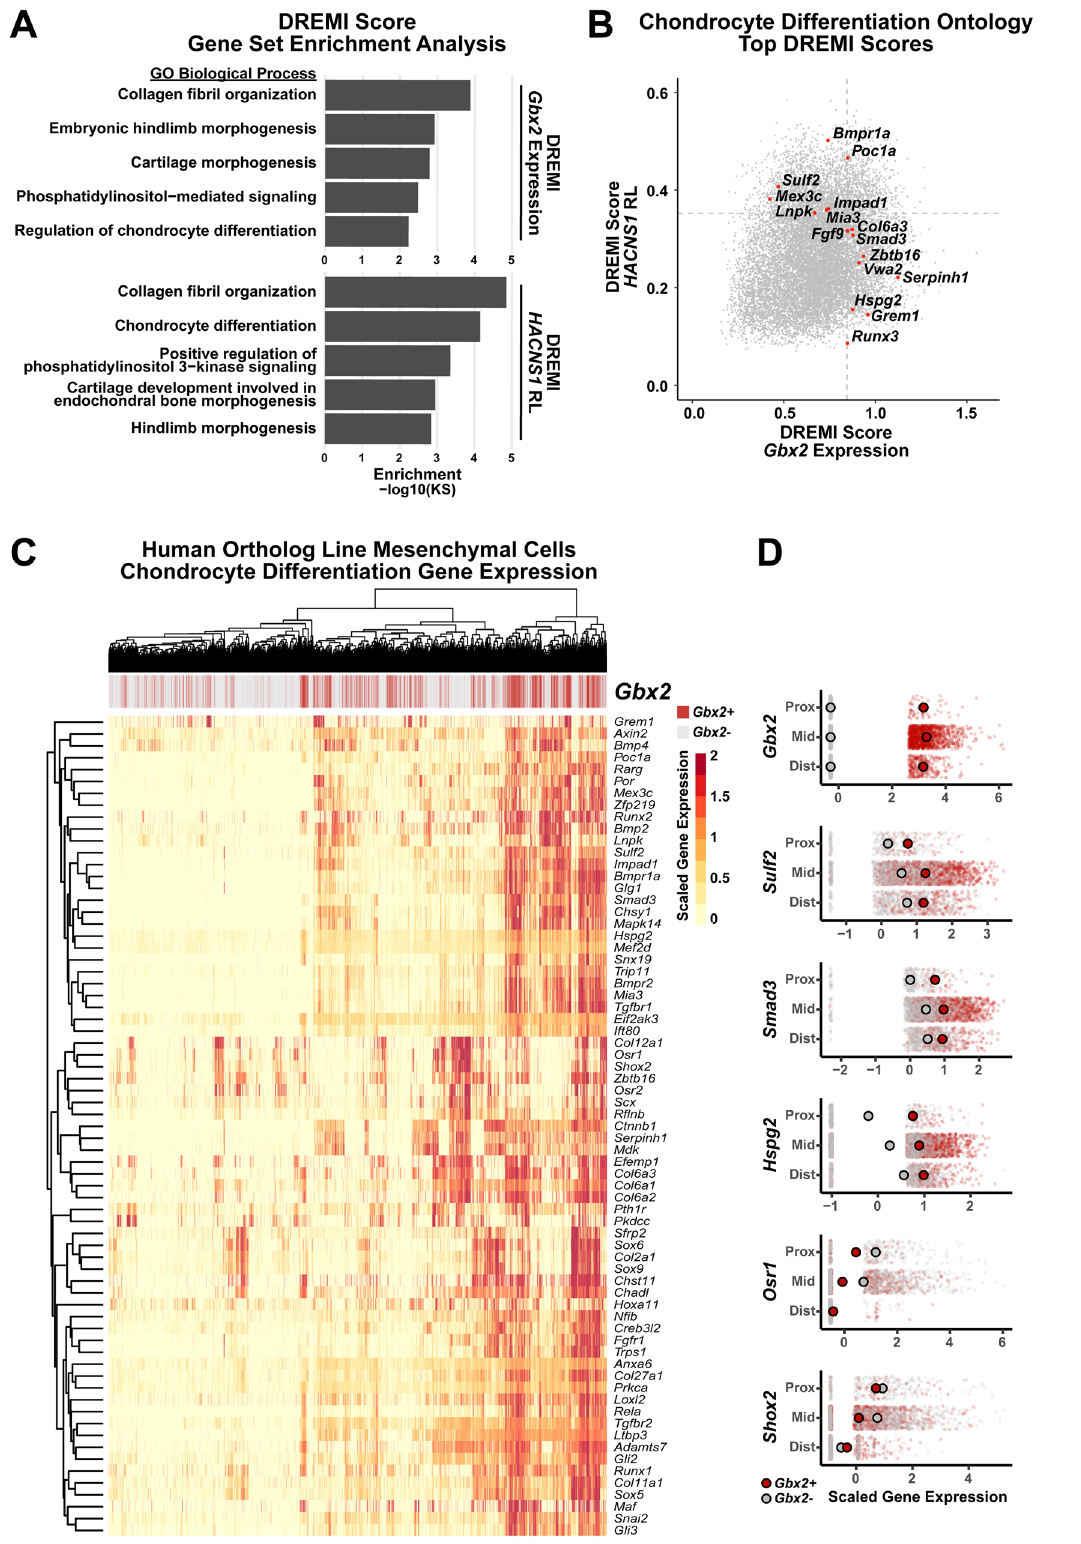
humerus), and intradigital (phalange to metacarpal or metatarsal length) and interdigital ratios. Again, we found no signi fi cant differences in digit length or autopod proportions between gen- otypes (Supplementary Fig. 6, Supplementary Data 7 – 9; Source Data). Although these analyses failed to detect morphological differences, it is possible that subtle phenotypes do indeed exist